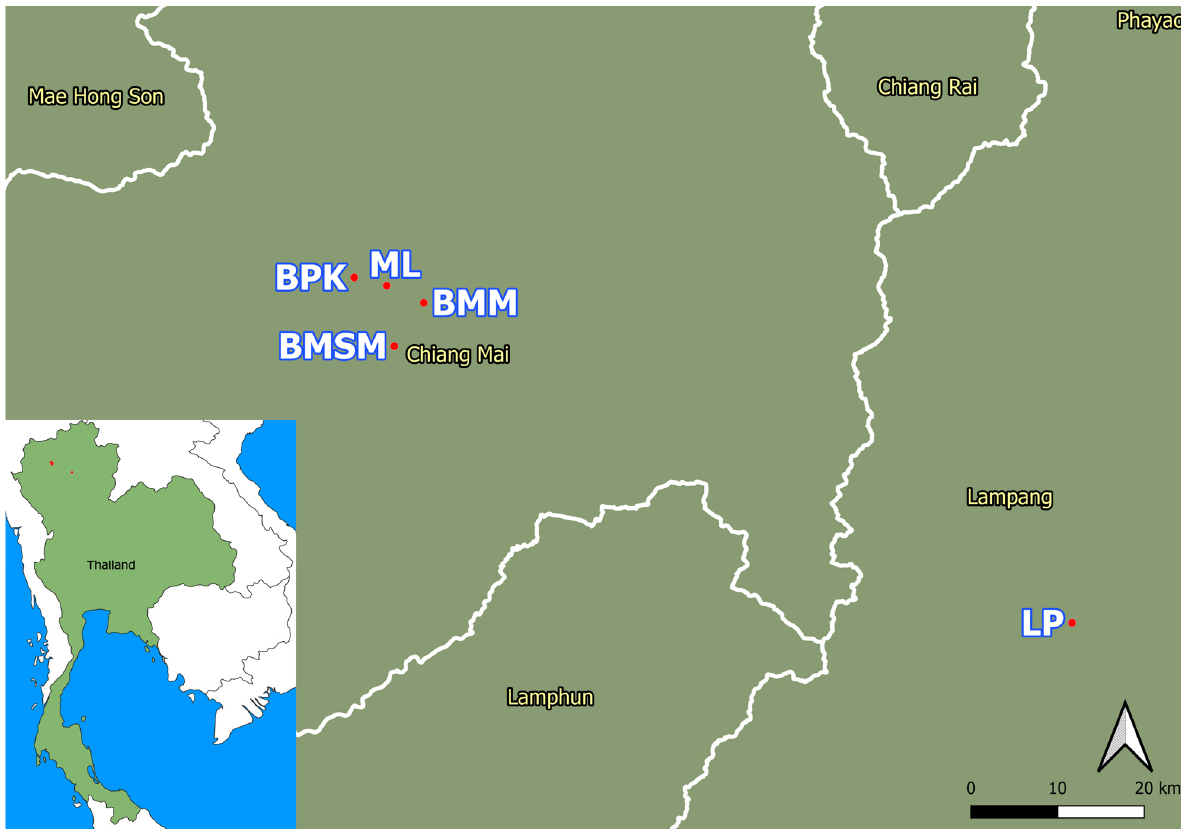
Figure 1. Location of the 5 study sites in the Chiang Mai and Lampang provinces, northern Thailand. White lines are province boundaries within Thailand.